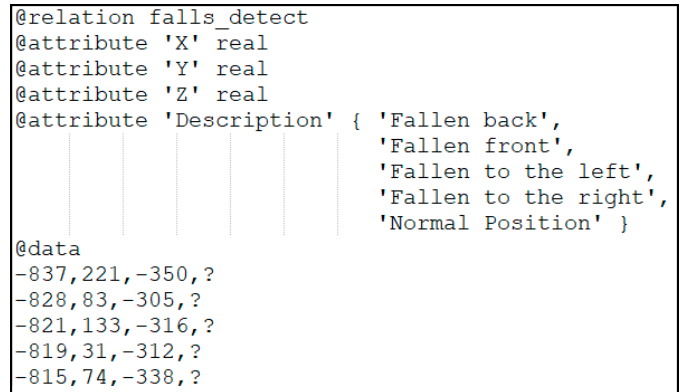
Figure 12. Sample of the test data file.